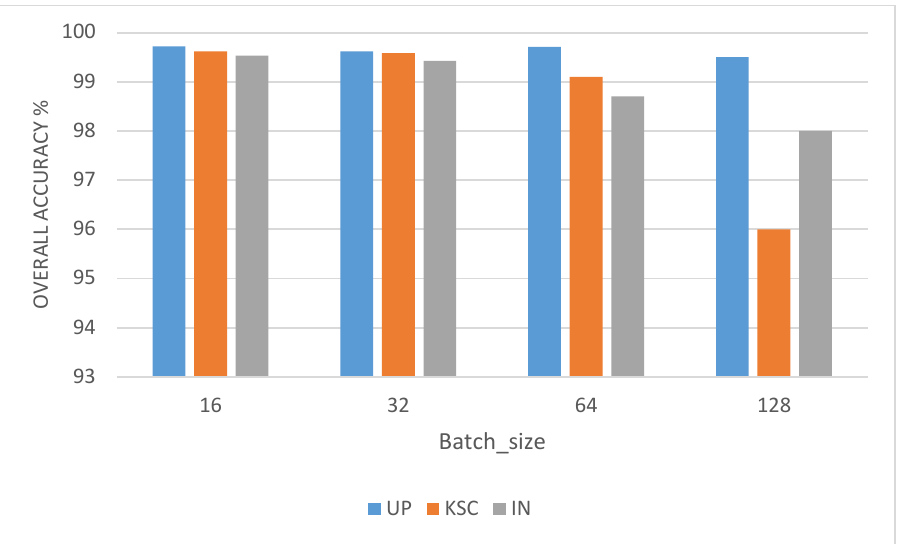
Figure 10. OA (%) of the proposed network with different batch_size in IN, UP, and KSC dataset.